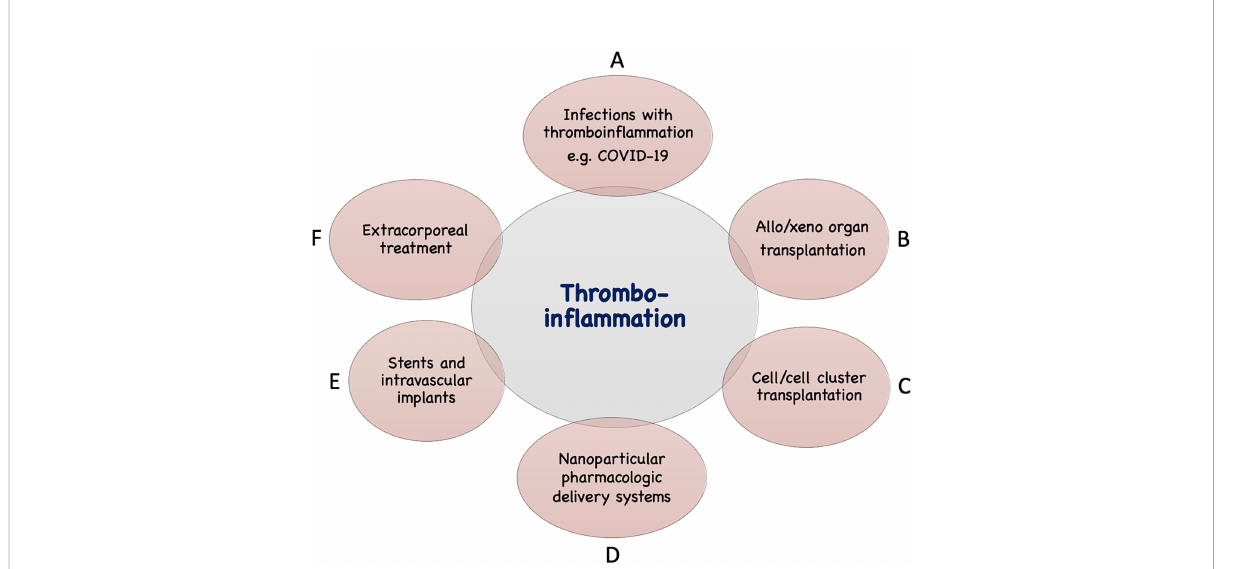
FIGURE 2 Examples of conditions and treatments which involve tromboin fl ammation. Activation of IIIS leading to thromboin fl ammatory reactions which may be detrimental occur in a number of clinical conditions, as well as treatments in general clinical practice. These include different infections such as with COVID-19 or sepsis (A) , transplantation: either of solid organs in allogeneic or xenogeneic setting (B) or of cells or cell clusters, e.g., islets of Langerhans (C) , drug distribution using nanoparticles in the body (D) , treatment with biomaterials, e.g., stents, intravascular devices (E) , and extracorporeal treatment such as, hemodialysis, cardiopulmonary treatment, ECMO, plasmapherisis etc (F)